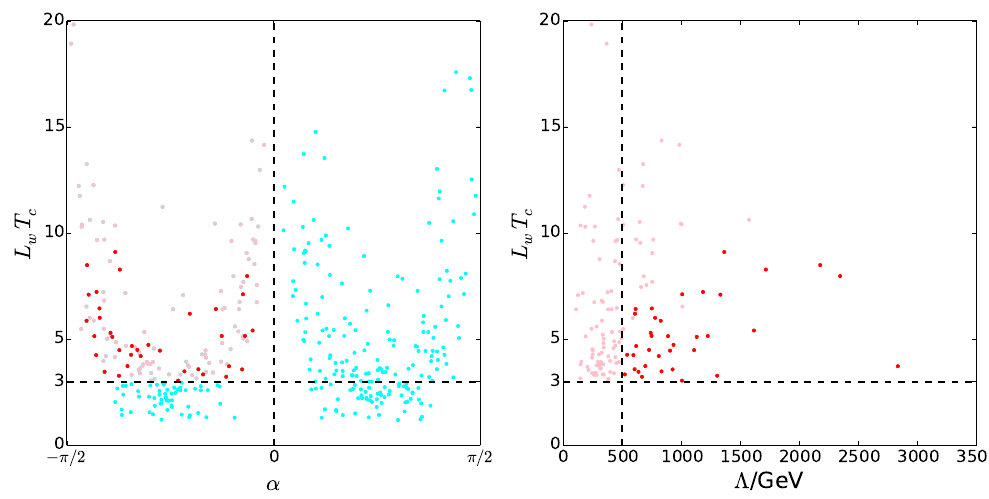
Figure 6 . Scatter plots in CPV phase (cid:11) vs. bubble wall width L w T c (left) and in (cid:3) vs. L w T c (right) for the models which satisfy all of the DM and strong (cid:12)rst-order PT constraints. The cyan points are excluded by the validity of the semiclassical framework L w T c (cid:21) 3 and the correct sign of baryon asymmetry (cid:11) < 0, while the pink and red points satisfy both conditions. The pink points are further ruled out by the large cuto(cid:11) condition (cid:3) > 500 GeV and w 2